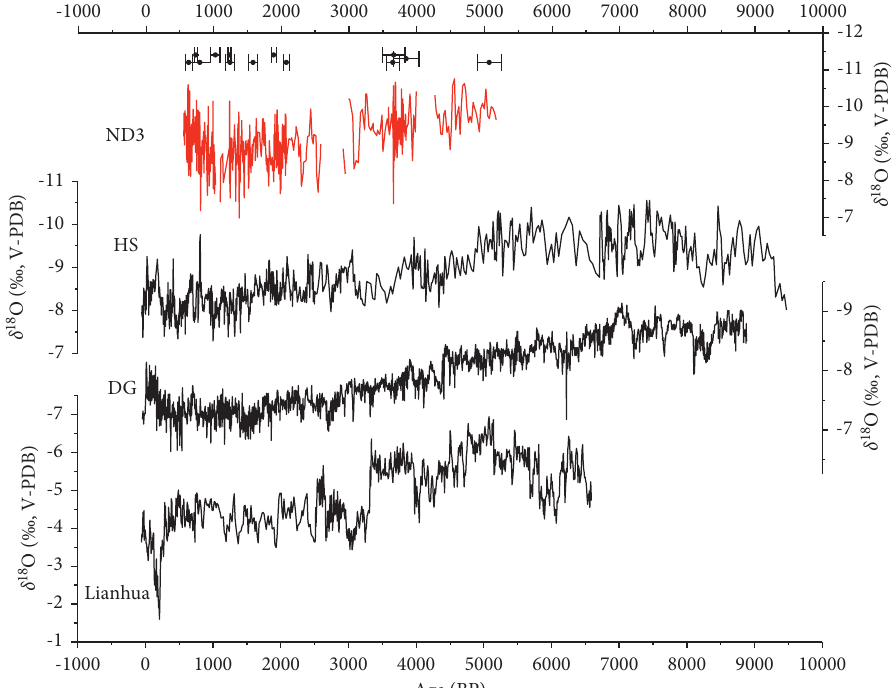
Figure 5: Comparison of stalagmites δ 18 O records from the mid-late Holocene. HS: Heshang Cave (Hu et al.,), DG: Dongge Cave (Wang et al.,), and Lianhua: Lianhua Cave (Jason et